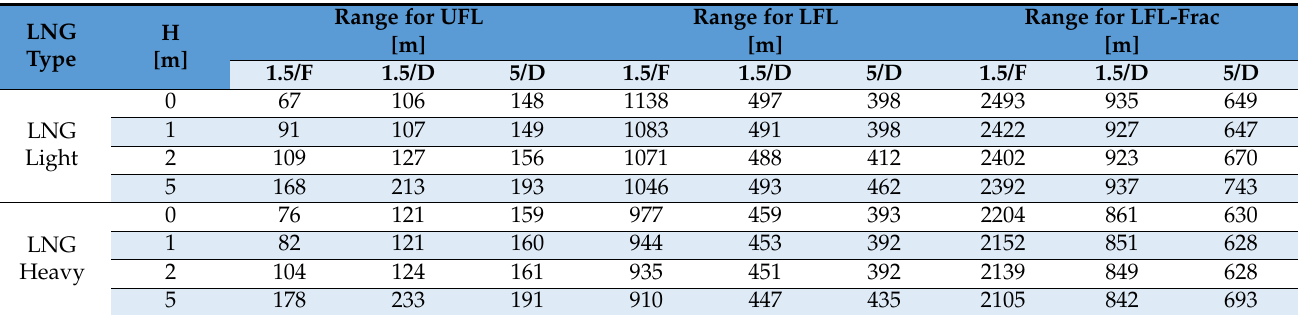
Table 6. Dispersion, leak, winter.